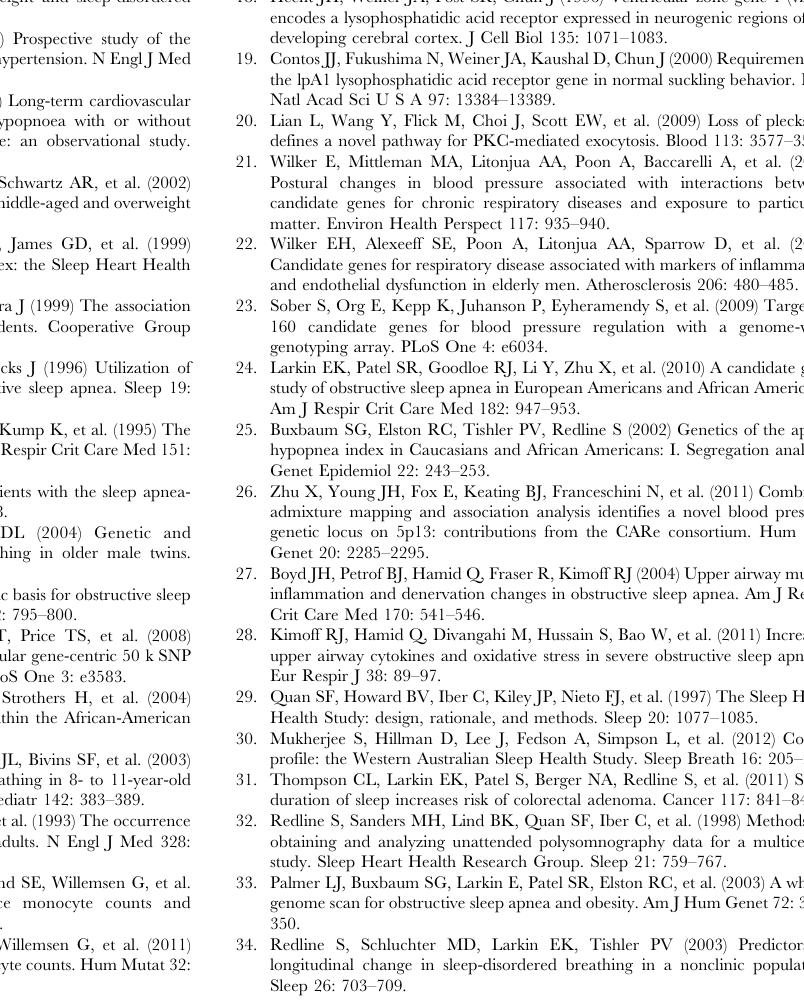
Figure S4 Quantile-quantile plot for obstructive sleep apnea in European ancestry individuals. This figure plots expected versus observed p-values from the association analyses of all SNPs against an apnea hypopnea index of 15 or greater in those of European ancestry. The plotted observed p-values are those from the meta- analysis after accounting for genomic